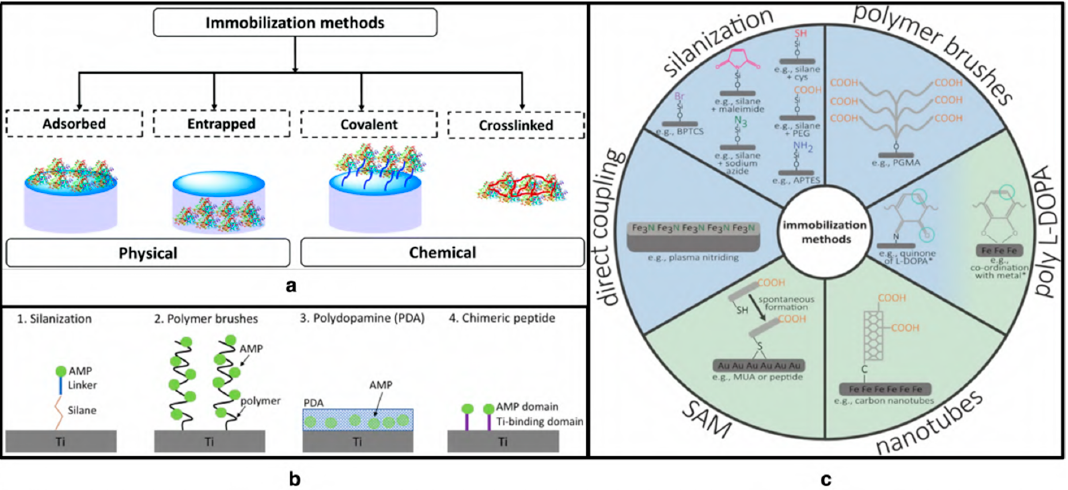
Figure 10. ( a ) Different peptide immobilization techniques on a solid surface (reprinted with per